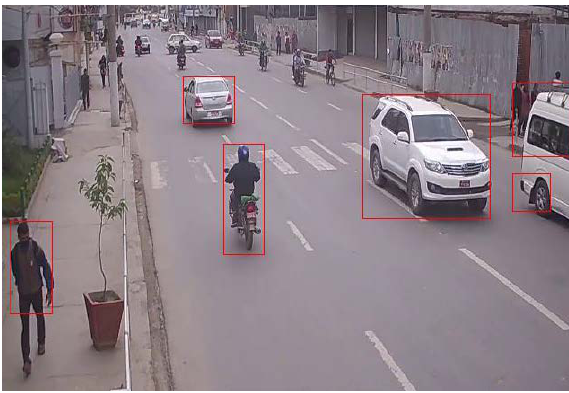
Fig. 2. Illustration of the motion detector algorithm. Large ‘moving’ area is detected (marked with rectangle).